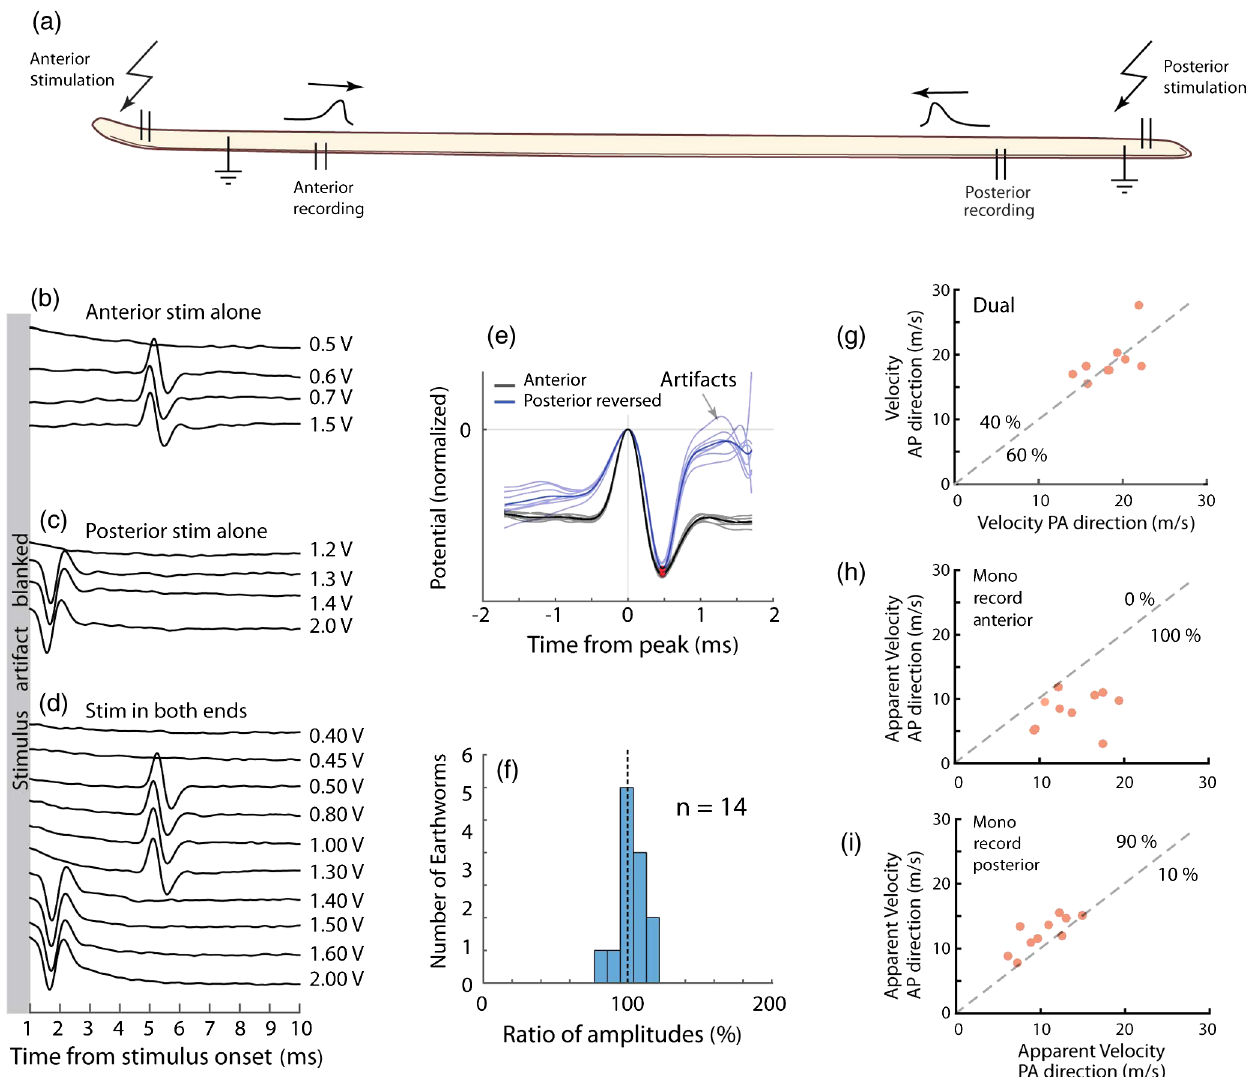
FIG. 1. Action potentials annihilate upon collision. (a) Experimental setup: Pairs of stimulation electrodes for generating APs in both ends, and pairs of recording electrodes are also placed towards both ends. (b) Stimulation of the anterior end of increasing strength and recording at the posterior end (consecutive traces, stimulation strength indicated) evokes APs to illustrate single same-fiber activation by (1) the threshold phenomenon and (2) the amplitude independence of stimulation strength (collectively known as the all-or-none phenomenon). (c) Similar to (b) with stimulation in the posterior end and single APs traveling in opposite directions (posterior recording). Note that the threshold is higher in the posterior than in the anterior end, and the latency is shorter when stimulating posteriorly. (d) Simultaneous stimulation in both ends with increasing strengths first evokes anterior AP until the strength is suprathreshold for generating APs in both ends (1.4 V). Here, the APs propagate from both the anterior and posterior ends and collide in the middle. Since the anterior and posterior APs never appeared together in the same recording, annihilation occurred. This was observed for all earthworms ( n ¼ 14 ). (e) Anterior (black lines)/posterior (blue lines, time-reversed) overlaid APs stem from the same nerve fiber as verified by their similarity in peak-to-peak amplitude (ordinate location of red dots, ratio ¼ 96% ). (f) Amplitude ratios for the population (PA/AP) are close to 100%. (g) Velocities based on the accurate method (using two sets of electrodes, i.e., dual recording) in the anterior-posterior (A – P) direction plotted against velocities in the reverse direction, i.e., posterioranterior (P – A) ( n ¼ 10 earthworms). A – P and P – Avelocity are the same according to a Kolmogorov-Smirnov test. (h) Apparent velocities using only one set of recording electrodes, as in Ref. [14], in the anterior end (i.e., mono recording). The velocity was estimated as the distance divided by time from stimulation to arrival, thus ignoring the impulse width and AP-generation delay, resulting in a disparity in velocities. (i) Velocities using the reverse configuration (recording in the posterior end), giving opposite disparity in velocities, which illustrates the methodological flaw of using mono